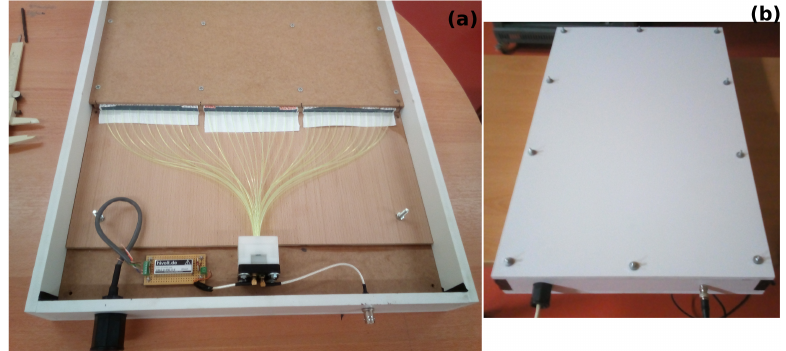
Figure 4. ( a ): The finished detector unit before closing the lid. At the bottom middle the SiPM and WLS fibers support structure are shown. At the bottom left the power supply module is shown. The UTP (left) and BNC (right) connectors are also shown. ( b ): The finished detector unit after closing the lid. The lid is firmly attached to the box with ten through hole